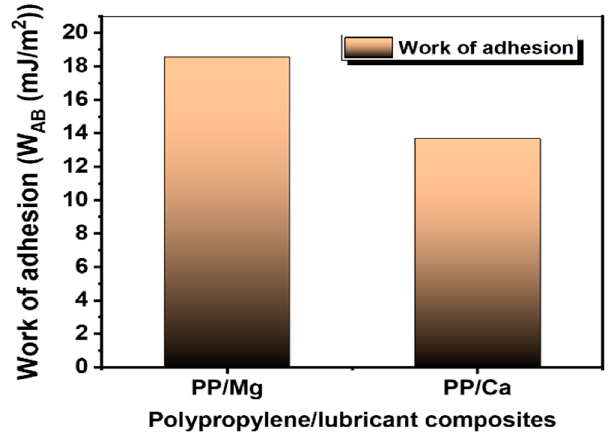
Figure 5. Work of adhesion of polypropylene/lubricant composites.